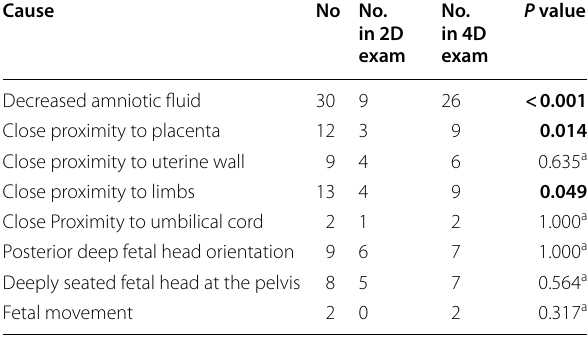
Values of statistically significant p values were marked in blod a Fisher exact test was used instead of Pearson χ 2 due to nonparametric data